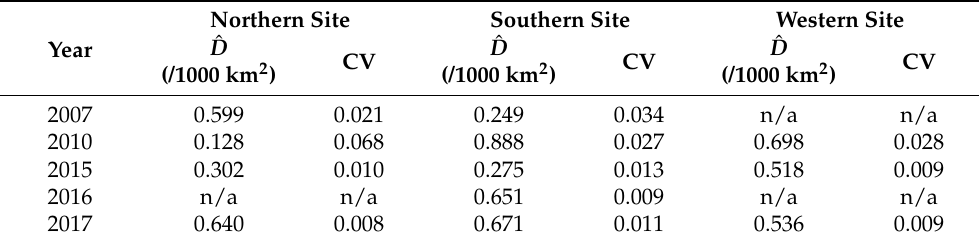
Table 5. Average population density estimates ( ˆ D ) and CVs for sperm whales at the Northern, Southern and Western sites for each survey